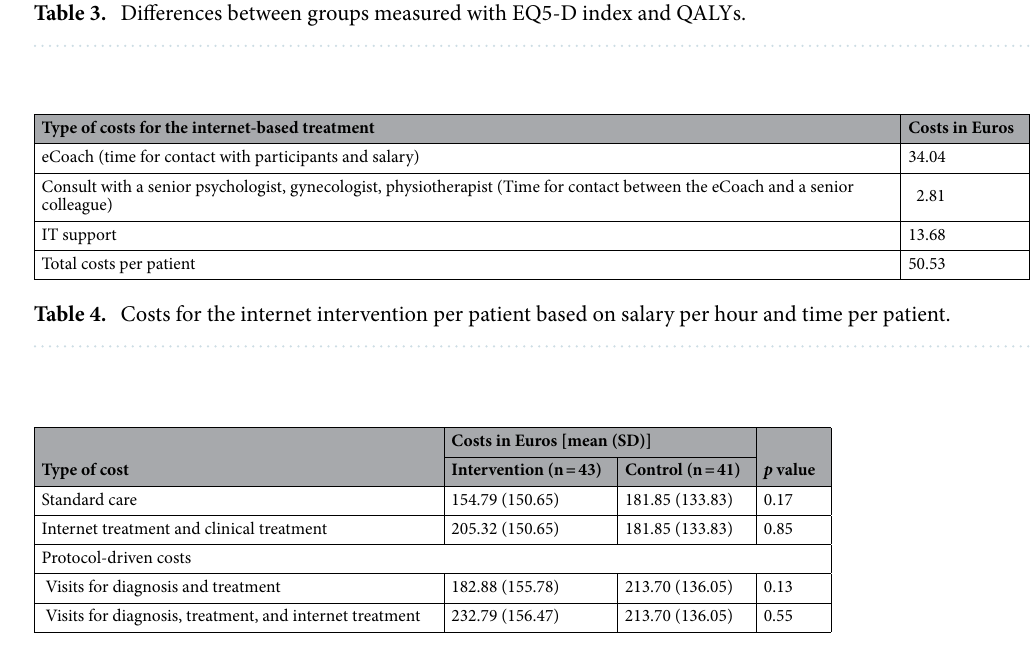
Table 5. Costs for clinical treatment.